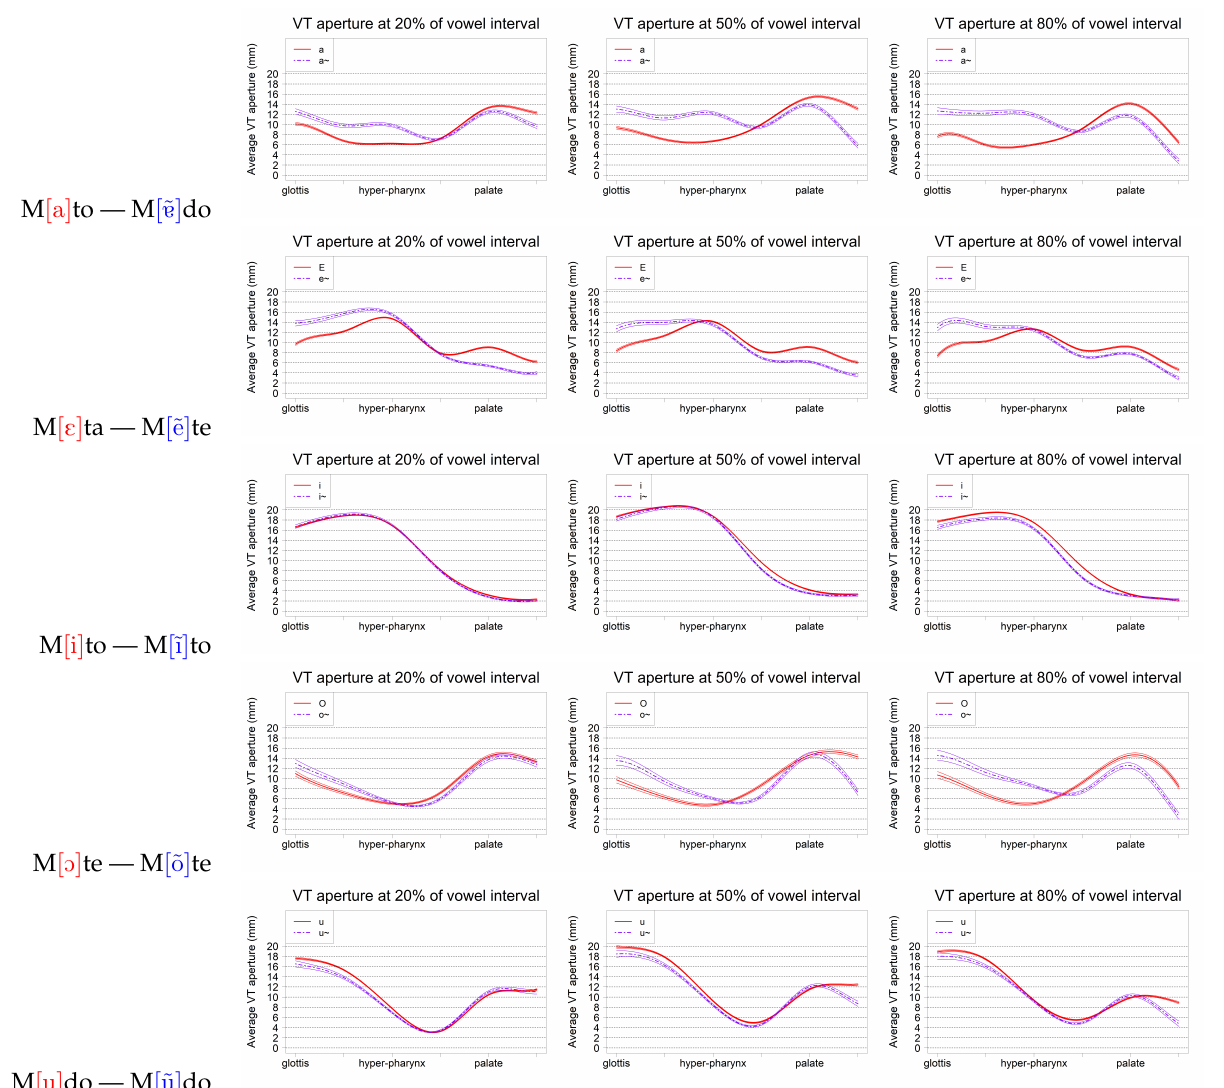
Figure 5. FLMMs showing the aperture function of the vocal tract for three time points. Each row presents the aperture function for 20%, 50%, and 80%, along the vowel. Each of the presented plots shows, in red, the curve for the oral and, in blue, the curve for the nasal. The curves for the oral bilabial context [p] showed similar patterns, and are thus not presented. The vertical axis represents the aperture, measured in millimeters (i.e., a higher value means a greater vocal tract